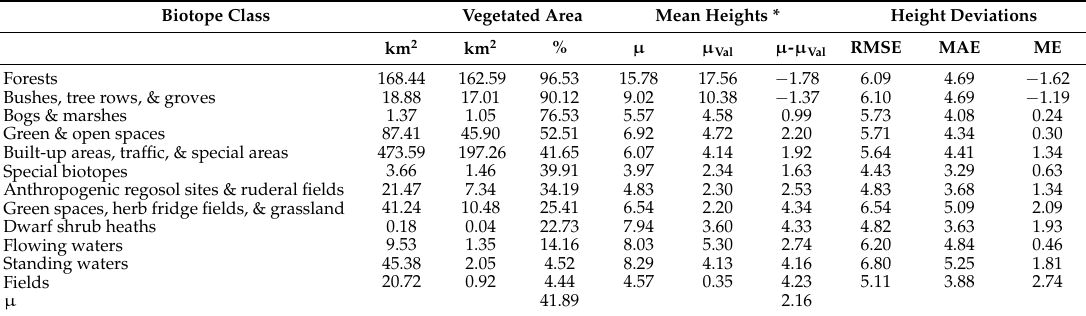
Table 3. Vegetated area (km 2 Veg , Veg %), Weighted mean vegetation heights ( µ ) and validation heights ( µ val ) and height deviations to validation heights (RMSE, MAE, and ME in meters) for the total vegetation on 12 biotope classes.